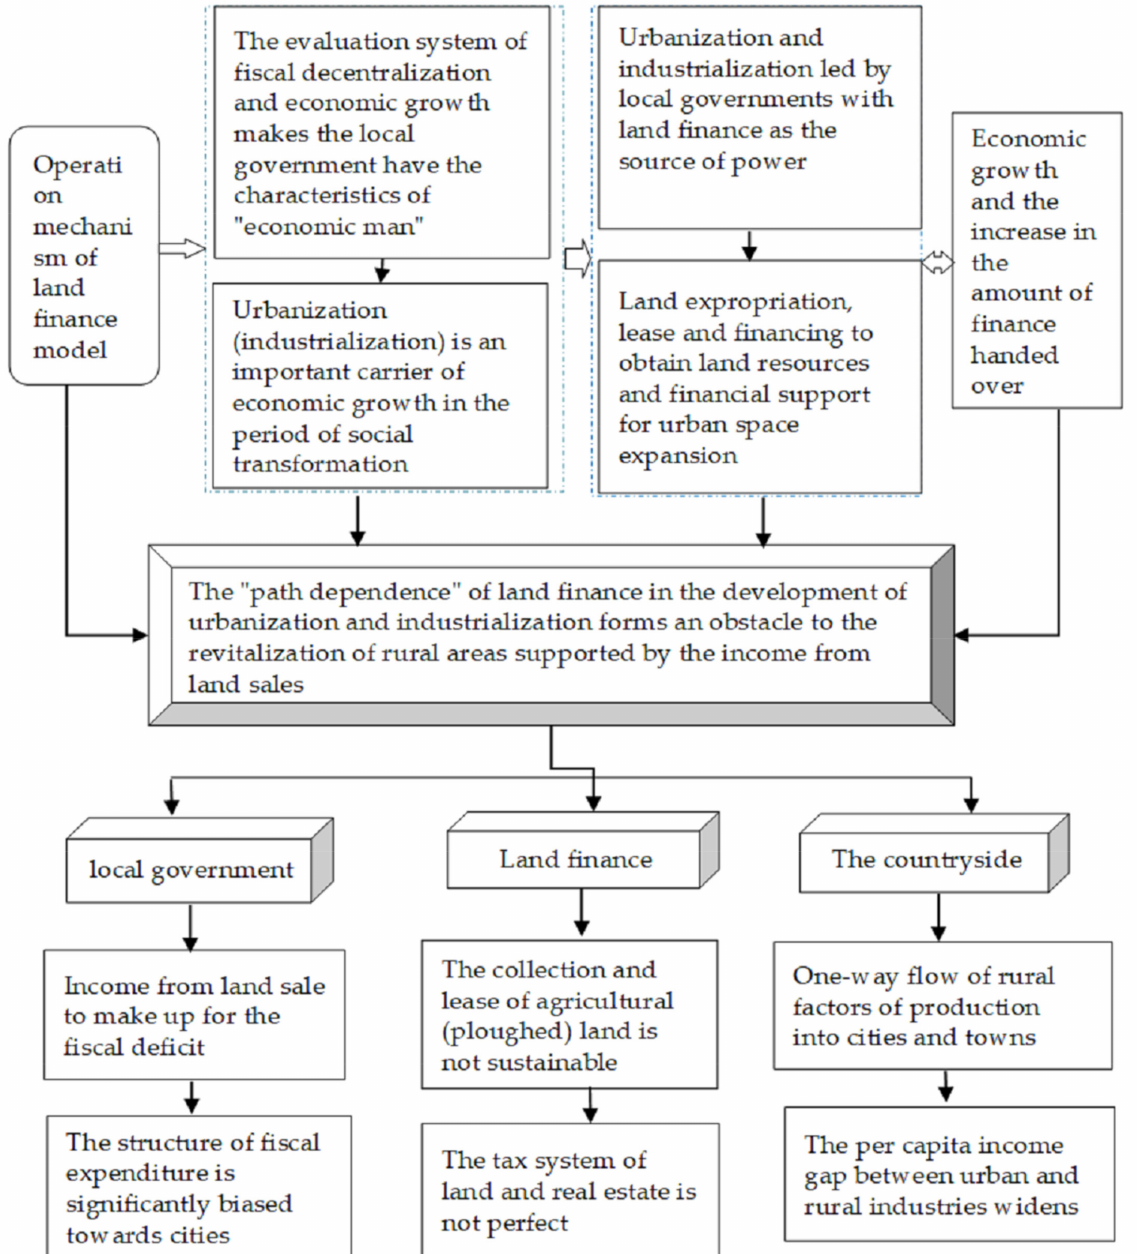
Figure 1. Operational framework of the potential obstacle mechanism of land transfer income supporting rural